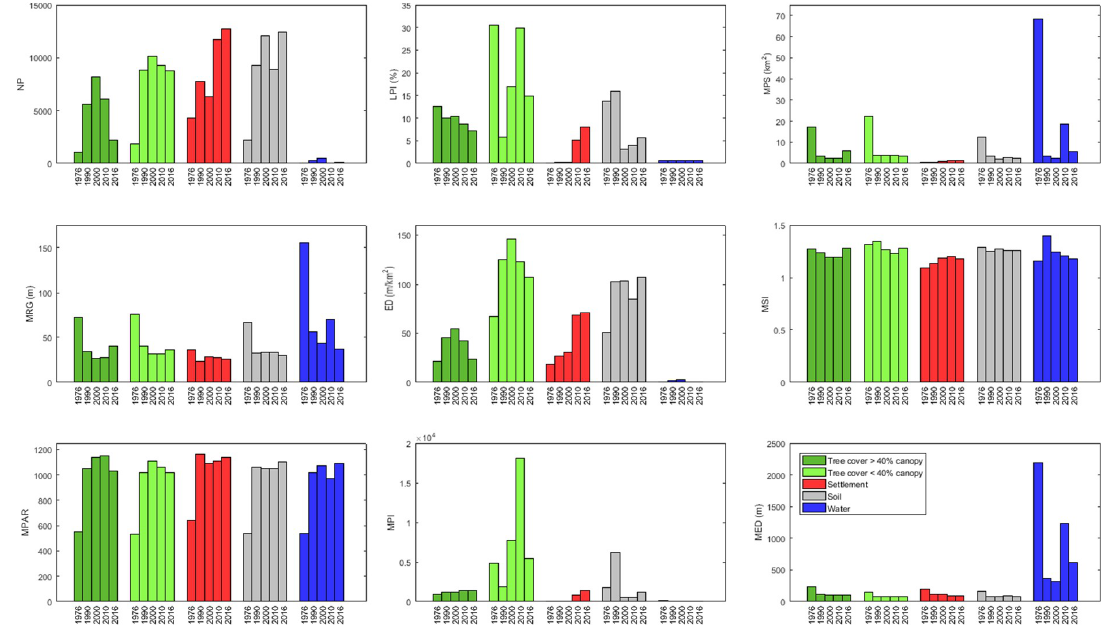
Figure 4. Land cover class level landscape matrix parameters graphs for 1976, 1990, 2000, 2010, and 2016.